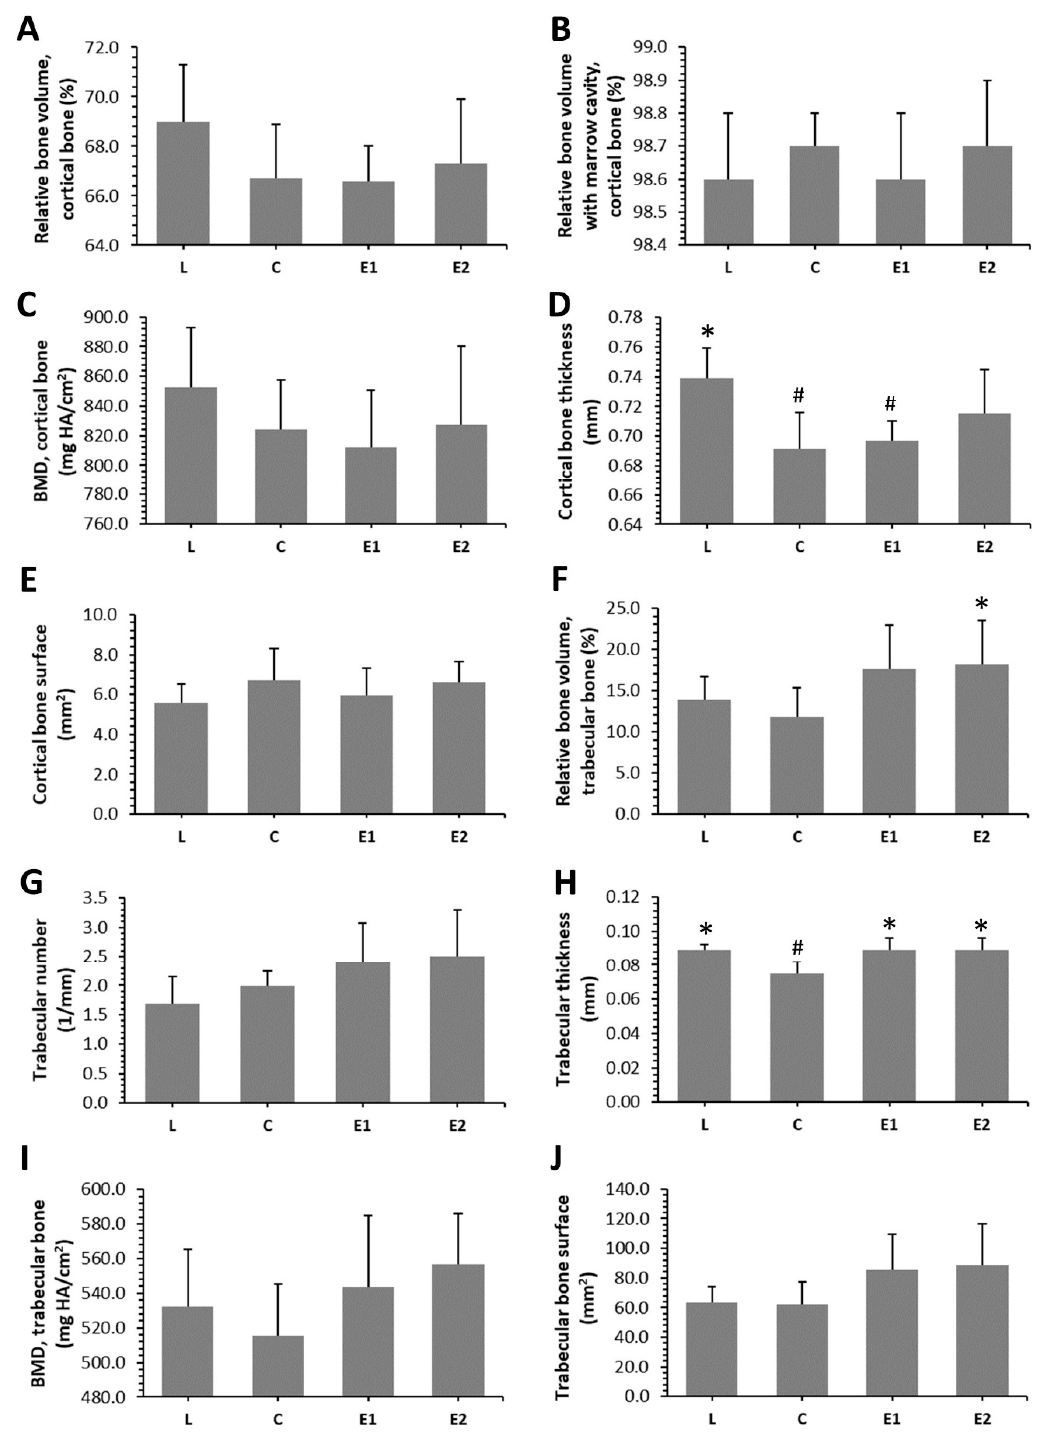
Figure 3. Parameters examined by microcomputed tomography in cortical ( A – E ) and trabecular ( F – J ) bone regions in ZDF rats from L, C, E1 and E2 groups. BMD—bone mineral density; HA—hydroxyapatite. * Significant differences versus C group ( p < 0.05). # Significant differences versus L group ( p < 0.05).